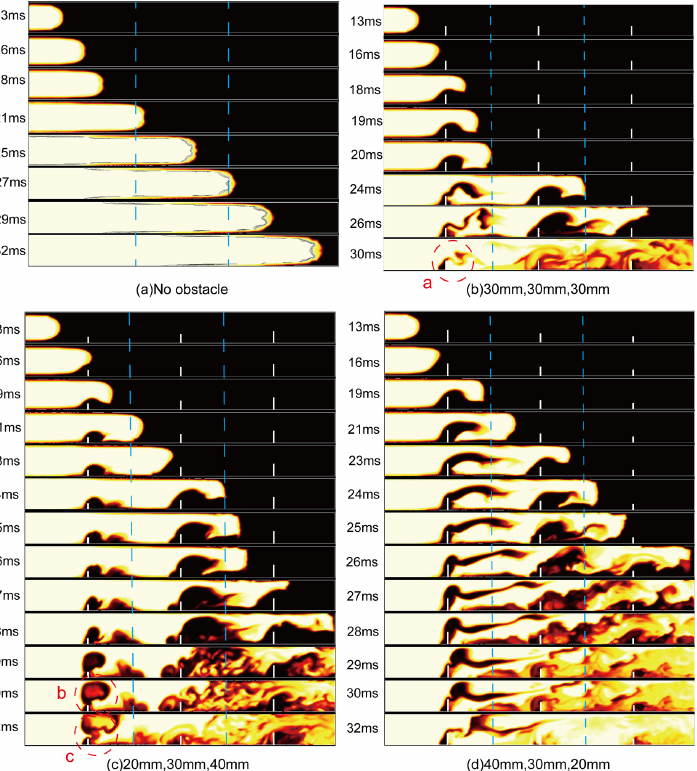
Figure 7. Simulated flame: Some details were marked with red boxes a, b, c. ( a ) Control experiment. ( b ) No change in blockage height 30 mm, 30 mm, 30 mm. ( c ) Increasing blockage height: 20 mm, 30 mm, 40 mm. ( d ) Decreasing blockage height: 40 mm, 30 mm, 20 mm.